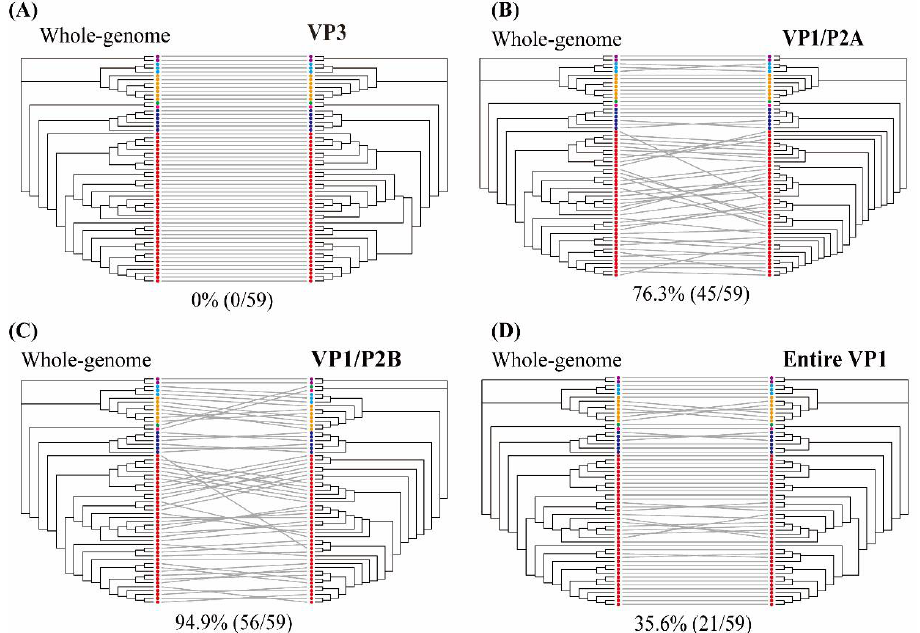
Figure 3. Tanglegram of hepatitis A virus (HAV) nucleotide sequences based on the whole- ( left ) and partial- ( right ) genome phylogenies. ( A ) VP3 region (1470–2207 nt), ( B ) VP1/P2A region (2984–3217 nt), ( C ) VP1/P2B region (2896–3289 nt), and ( D ) entire VP1 region (2172–3125 nt). Color indicates individual six sub-genotypes of human and one of sub-genotype of animal in HAV strains. Whole-genome and partial-genome phylogenies were generated using the maximum likelihood method. Full lines indicate significant phylogenetic conflicts. Grey lines indicate phylogenetic clade patterns falling between two different regions.